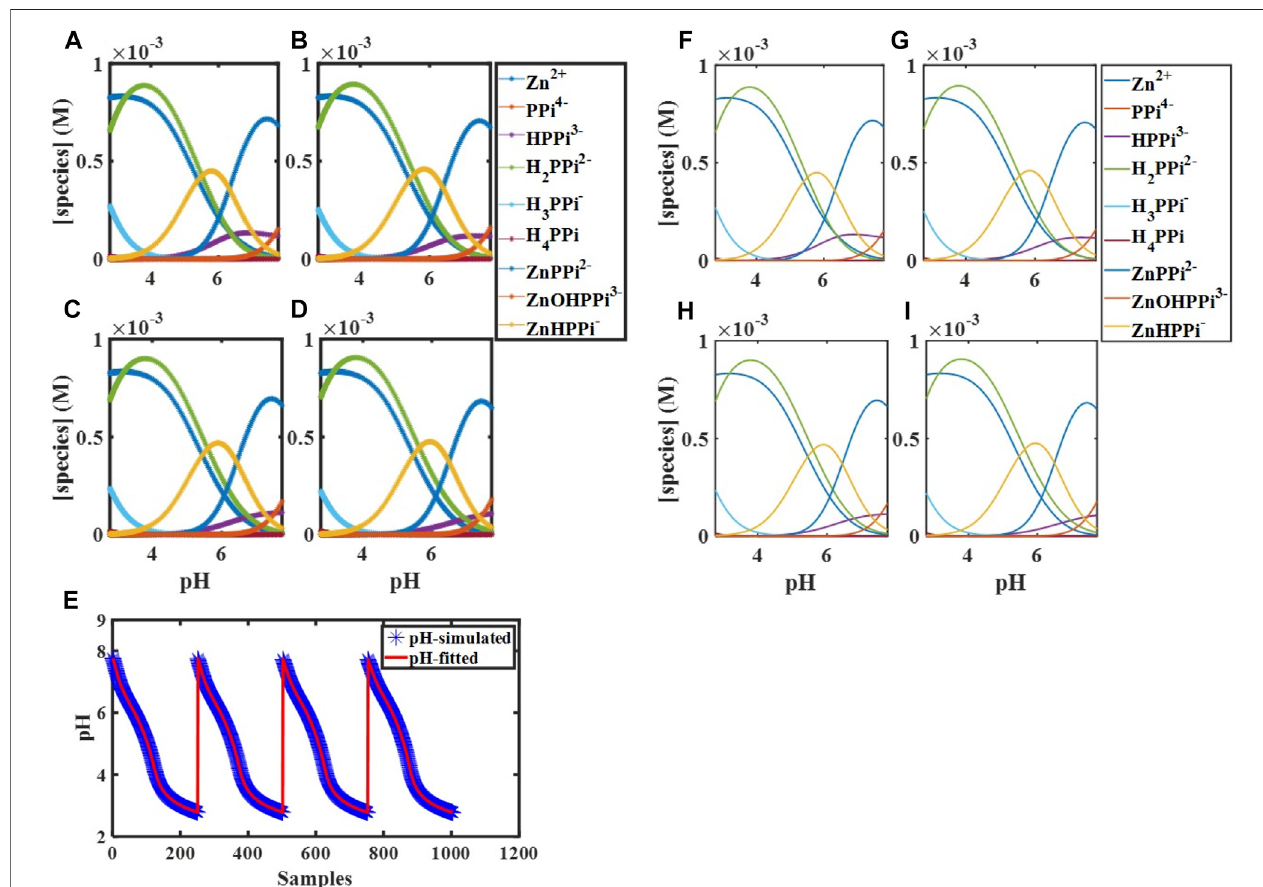
FIGURE1| Simulatedconcentrationpro fi lesfor [ PPi ] 0 tot (cid:1) 9.9 × 10 − 4 M, [ Zn ] 0 tot (cid:1) 8.7 × 10 − 4 M,and [ H ] 0 tot (cid:1) 0 Mat (A) 283 K, (B) 288 K, (C) 293 K,and (D) 298 K; (E) Simulated and fi tted pH for [ d